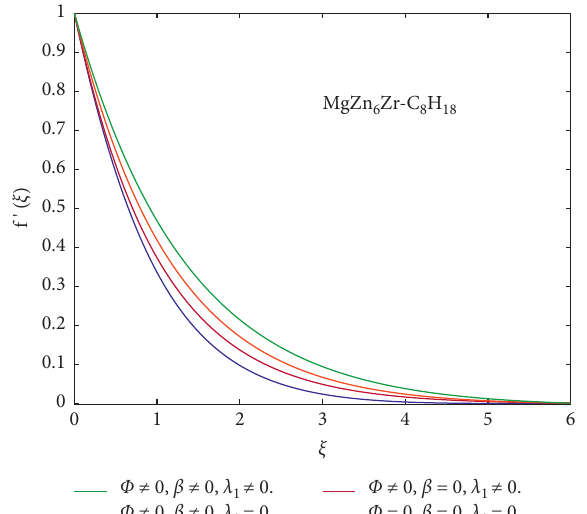
Figure 2: Comparision of velocity field in MgZn